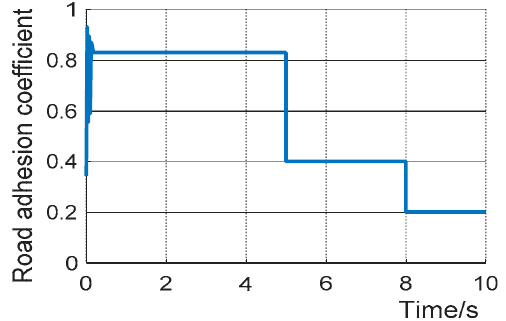
Figure 12. Road type curve.